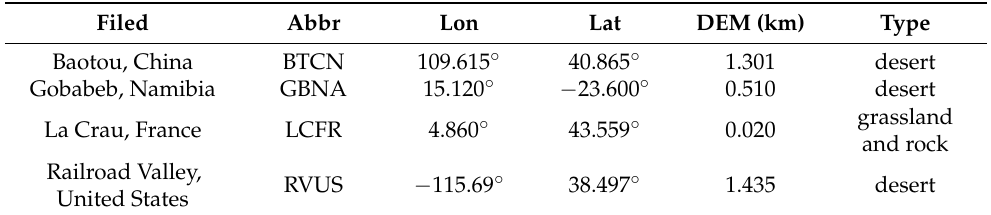
Table 2. Calibration site information.